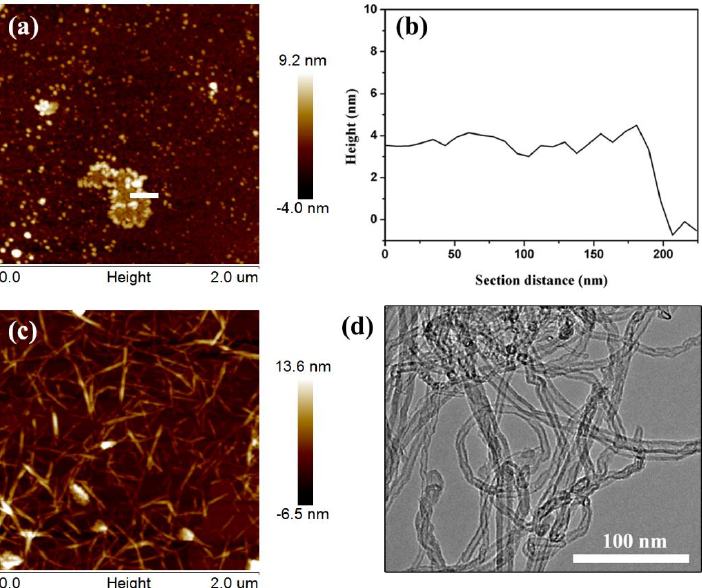
Figure 1. ( a ) Atomic force microscope (AFM) image, and ( b ) height profile image of the graphene nanosheet; ( c ) AFM image of NFC; ( d ) transmission electron microscope (TEM) image of CNTs.